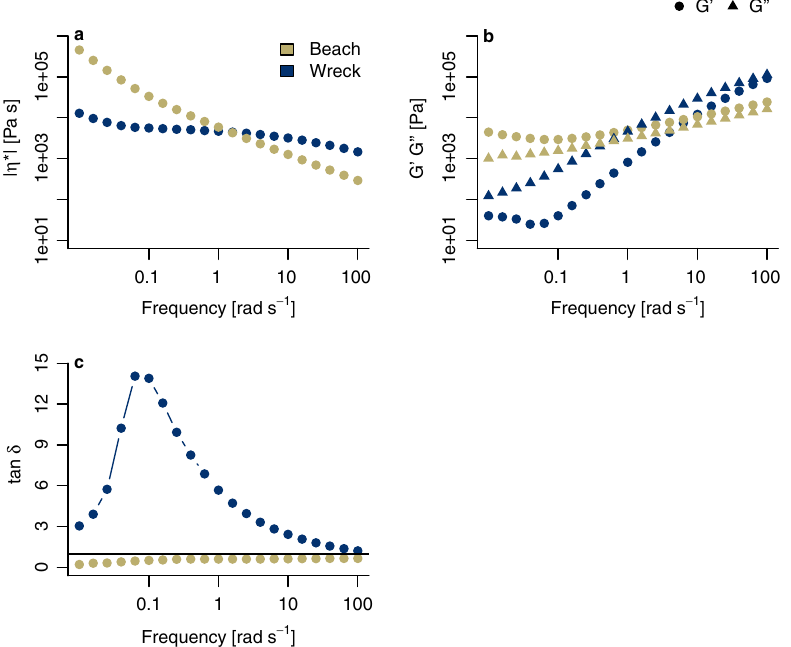
Figure 7. Rheological properties of MP resin pellets from a beach in the Wadi el Gemal national park, Egypt, and the SS Hamada wreck in the Red Sea. MP from the wreck showed a behavior typical for pristine PE, while beached pellets exhibited a more complex microstructure. ( a ) Log–log-scaled complex viscosity |η*| (Eq. 2). A Newtonian plateau at low frequencies was solely found for MP inside the wreck. ( b ) Storage modulus G´ (circles) and loss modulus G´´ (triangles) on a log–log scale. G´ was constantly higher than G´´ in the case of pellets from the wreck, which is typical for pristine LDPE. For beached MP, the opposite was observed. This indicates a more complex microstructure. ( c ) Loss tangents tan δ was always lower than one (solid line) in the case of beached pellets and higher than one for MP from the wreck. Note the logarithmic scale on the